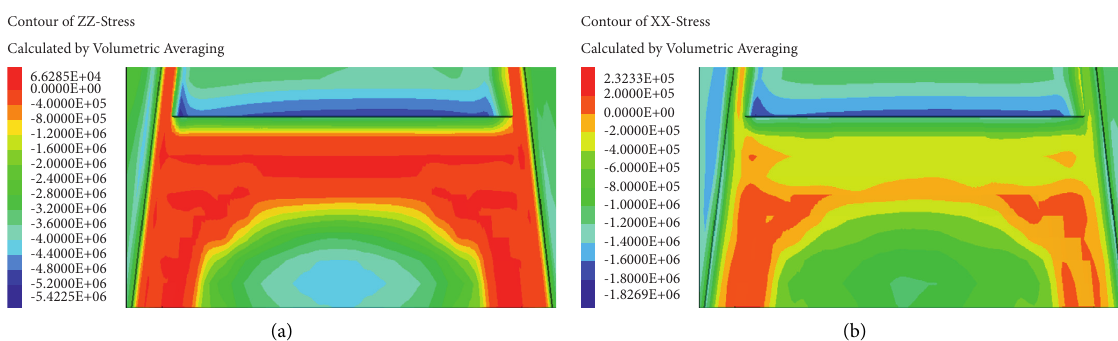
Figure 15: Stress distributions while excavating a face for 45m. (a) Vertical stress. (b) Horizontal stress.